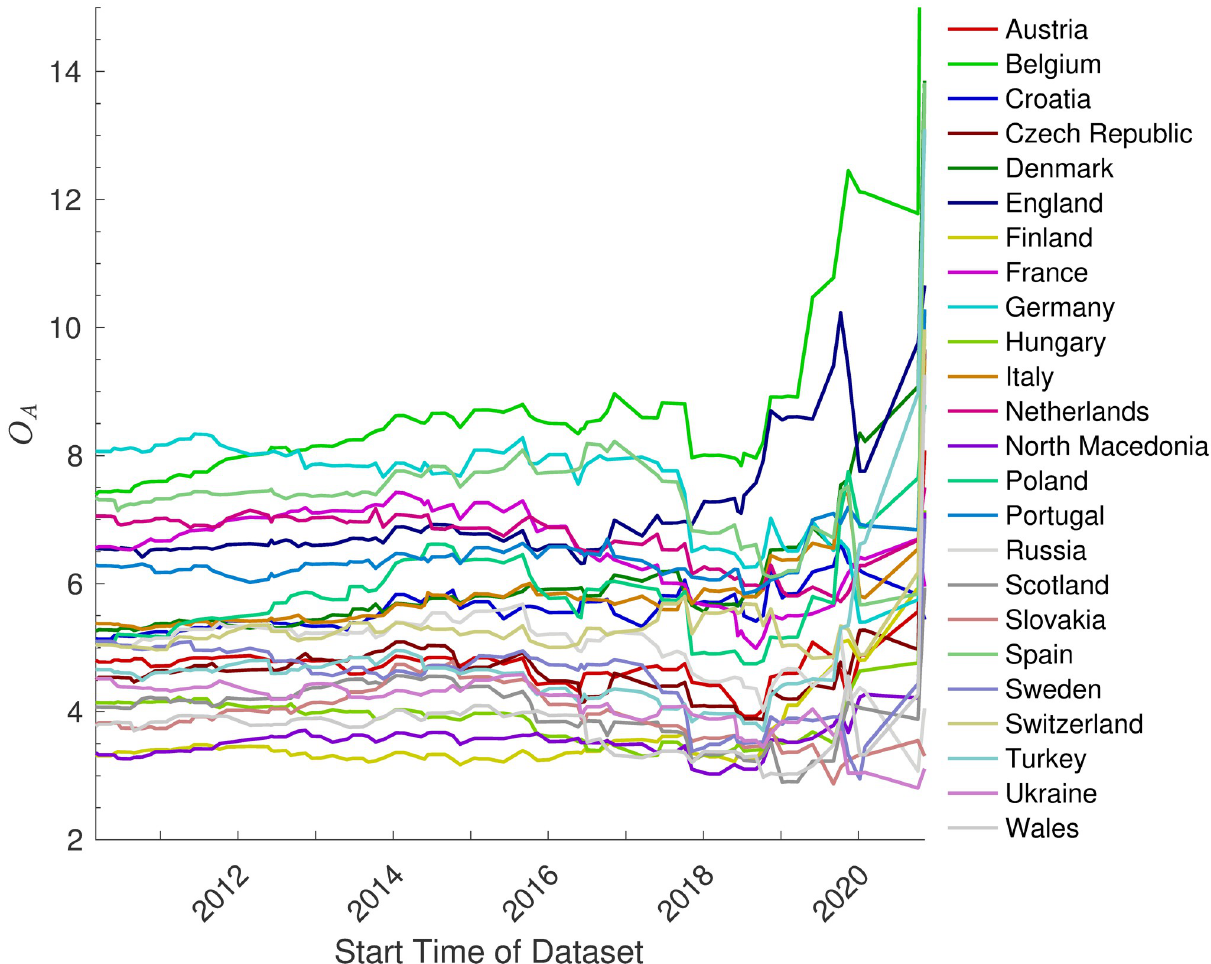
Fig 11. The attacking strengths as a function of the start date of the dataset used. This shows how the predicted attacking strengths, O A of the 24 teams that competed in Euro 2020 vary depending on the start date of the dataset of matches. Note that in all cases the end date was May 28, 2021—the date of submission to the